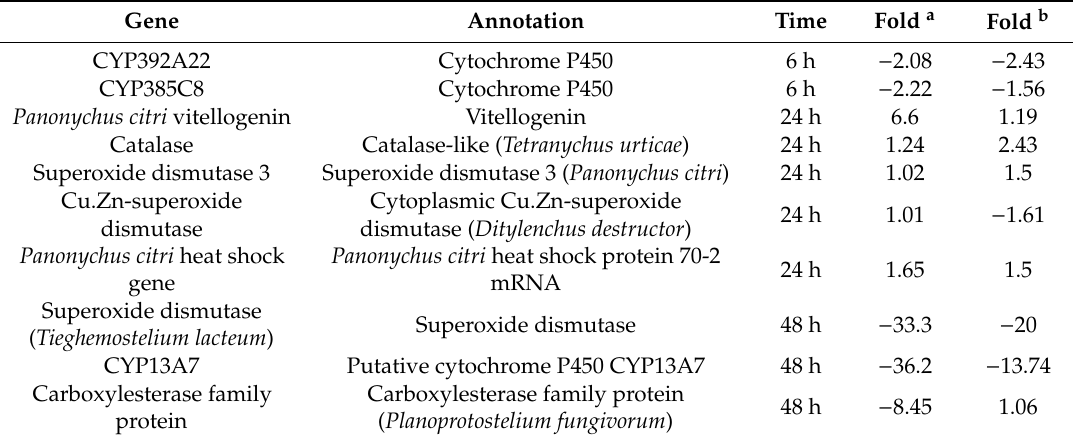
Table 4. Transcriptome data